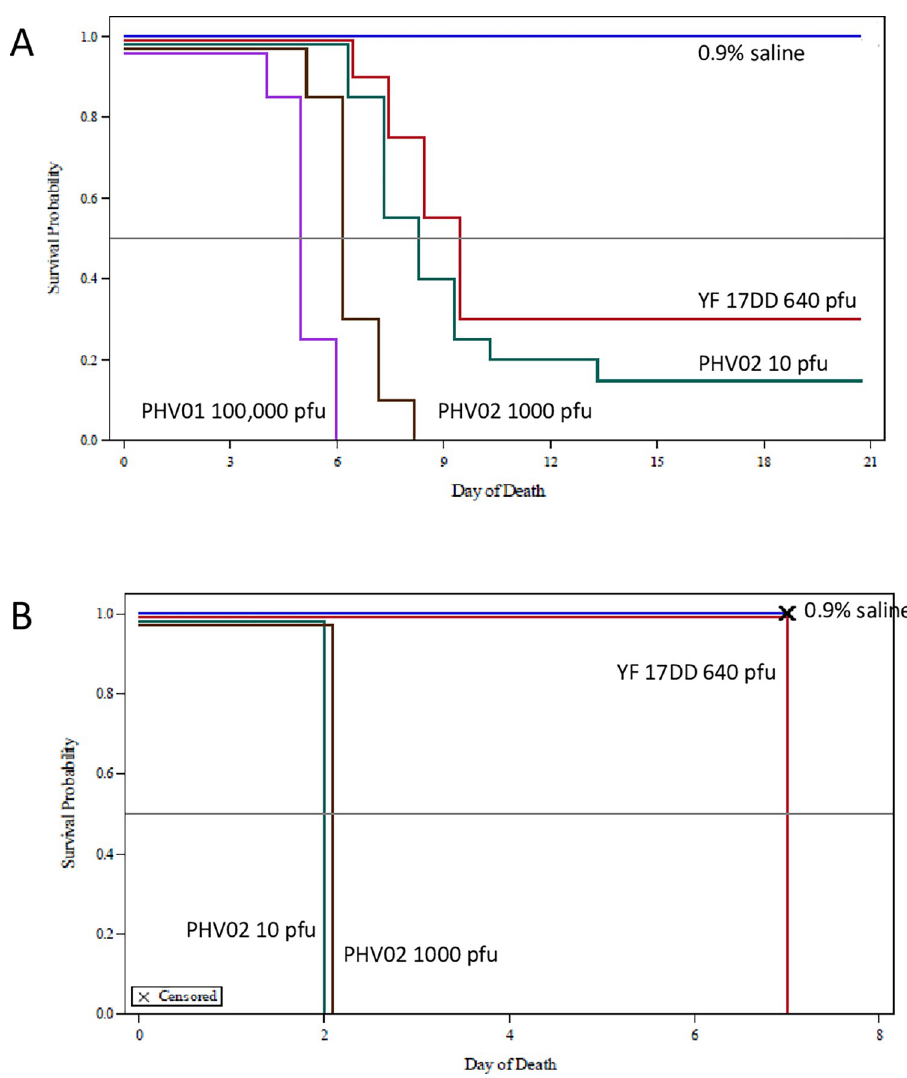
Fig 2. Survival distribution, infant mice and hamsters inoculated by the IC route. A. 8-day-old ICR mice. Twenty μ L of PHV02 at graded doses or YF 1DD vaccine were inoculated into 2 litters (10 suckling pups/litter). The doses injected in 20 μ L were 100,000, 1000, or 10 pfu for PHV02 groups and 640 pfu for YF 17DD. Animals were observed for 21 consecutive days and clinical signs and deaths recorded. All mice died in the intermediate and high dose groups, 85% died in the low dose (10 pfu) group and 70% died in the reference group receiving 640 pfu of YF17DD. B. 8-day-old Golden hamsters. Twenty μ L of PHV02 at graded doses or YF 17DD were inoculated into 2 litters (8-10 suckling pups/litter). The doses injected in 20 μ L were 1000 or 10 pfu for PHV02 groups and 640 pfu for YF 17DD. All infant hamsters died, but the YF 17DD animals had a statistically longer survival time (see text). Since all animals in the test article groups died by Day 7, the study was terminated at that